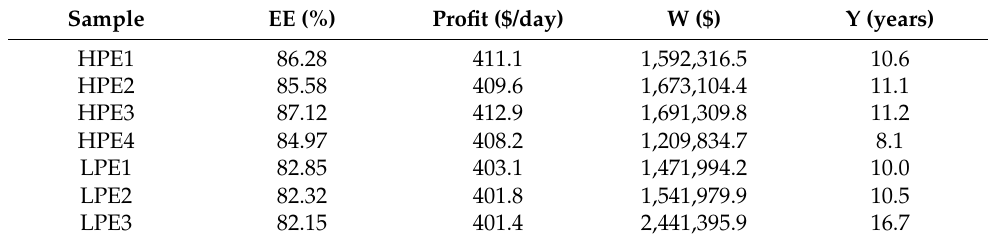
Table 5. The economic profits of a 1MW/4MWh VRFB system with different purities of